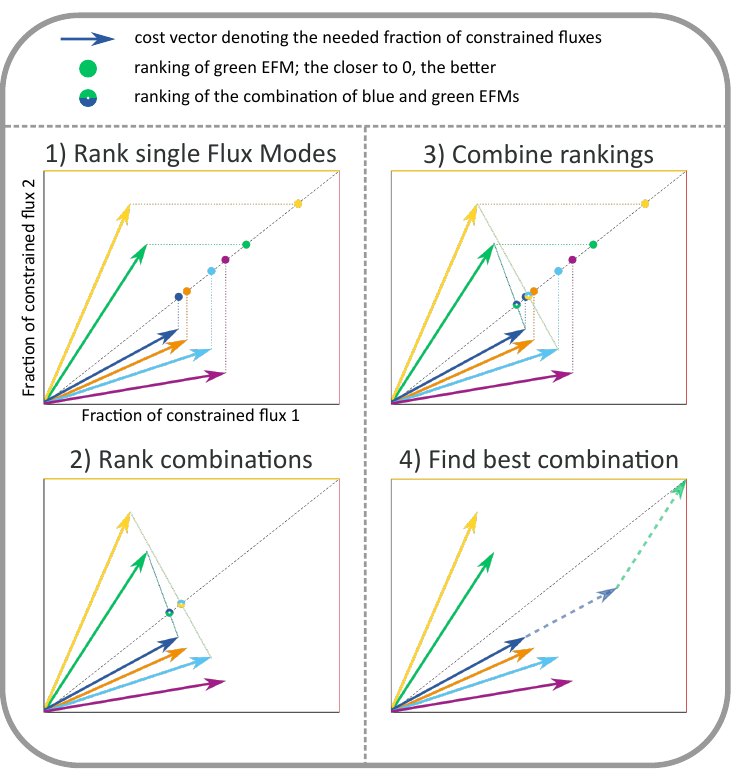
Figure A1. The optimal combination of EMs can be found by visual inspection of the cost vectors, as described in the main text.